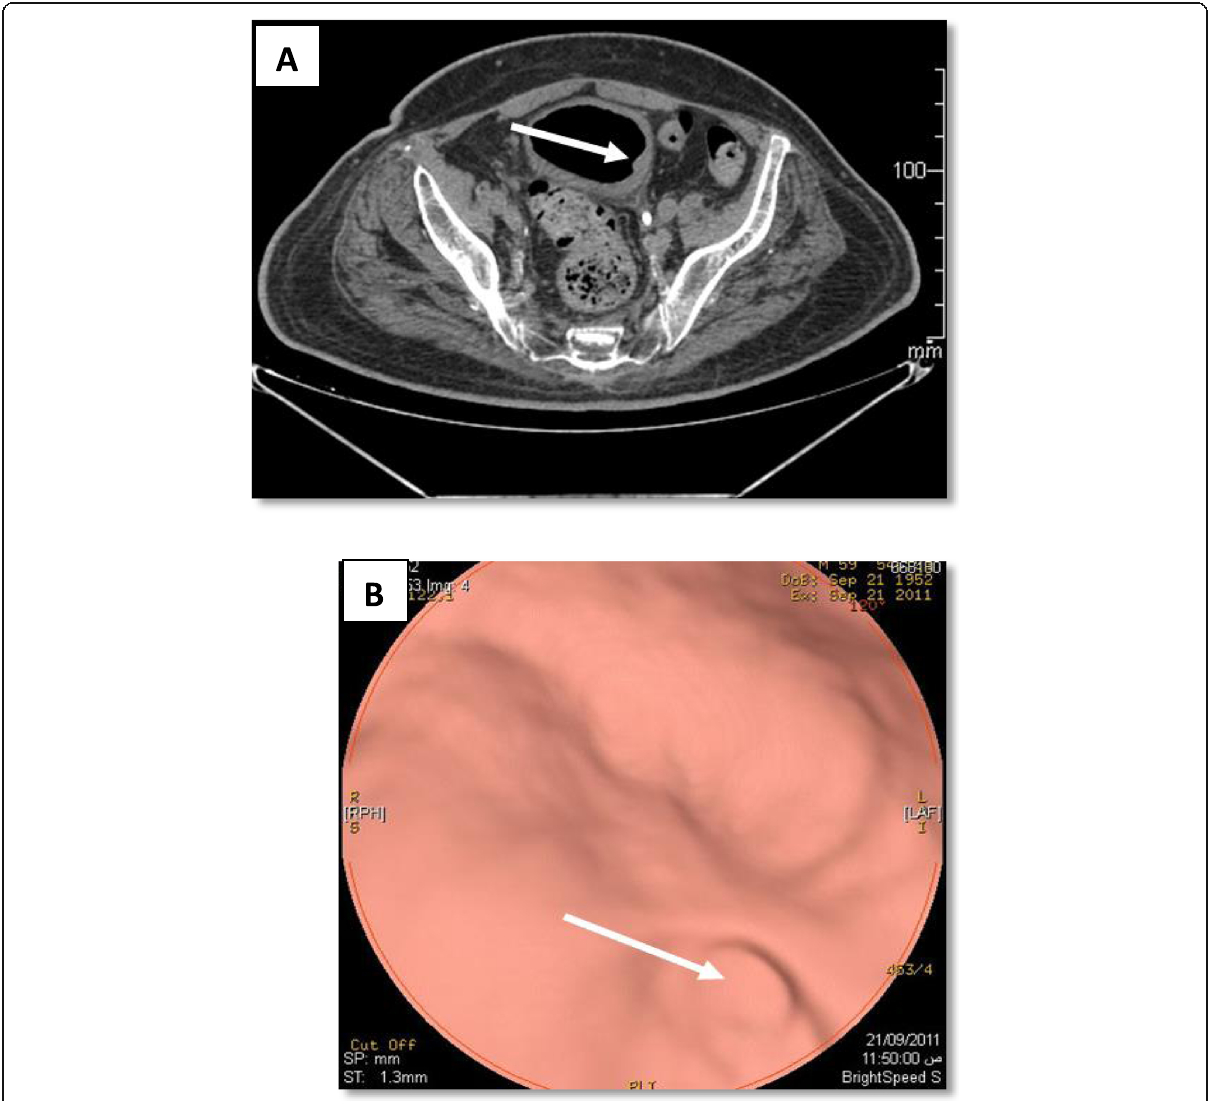
Fig. 4 a Male patient 59 years old presented with gross hematuria and history of trans-urethral resection of bladder cancer 2 years ago. Axial CT image shows circumferential mural thickening and a small left lateral wall polyp about 5 mm. b Virtual image confirmed the thickened wall seen by axial images. A small polypoidal mass (arrowed) 4 – 5 mm can also be seen. Biopsy taken and revealed squamous cell carcinoma grade I